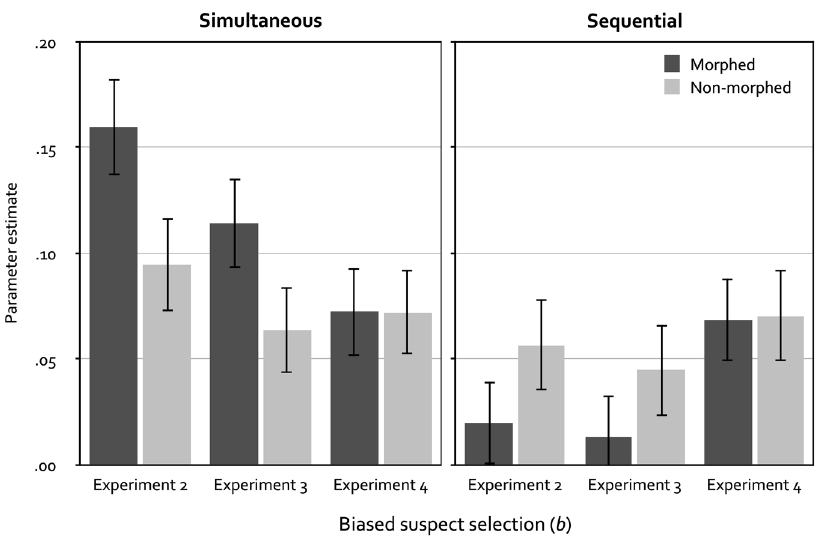
Figure 4. Parameter estimates of parameter b reflecting the probability of biased suspect selection as a function of lineup format (simultaneous vs. sequential) and the type of lineup fillers (morphed vs. non-morphed) in Experiments 2, 3 and 4. The error bars represent the standard errors.